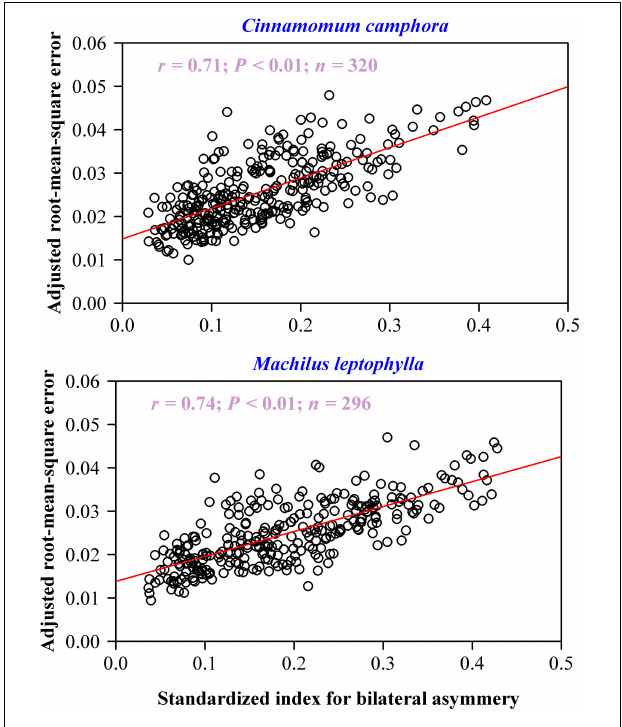
FIGURE 6 | Correlation between the adjusted root-mean-square error and standardized index for lamina bilateral asymmetry. In each panel, the open circles represent the observations; the red straight line represents the regression line; r is the coefficient of correlation; n is the sample